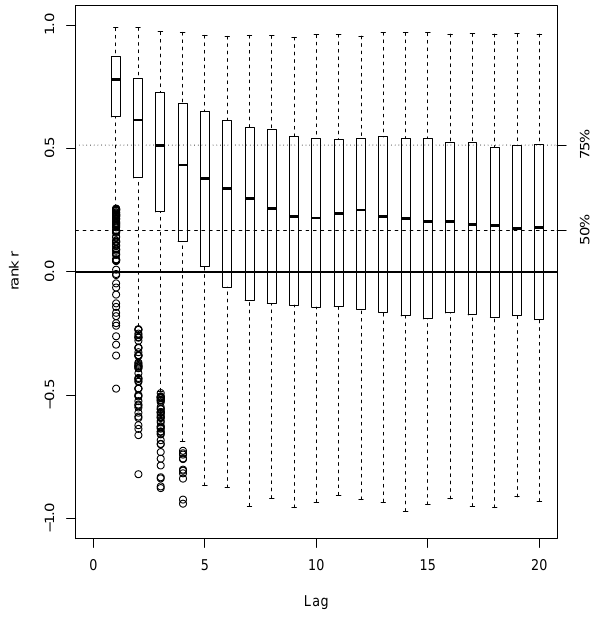
Fig. 1. Distribution of autocorrelation functions for each grid point in the Kington (1988) SLP data set, for lags between 0 and 20 days. Each box and whisker plot is drawn for a lag and all grid points with data. The boxes represent the median ( q 50 ), 25th ( q 25 ) and 75th ( q 75 ) quantiles of the distribution. The up- per whisker is min(1.5( q 75 − q 25 ) + q 50 , max ( C )); that is, circles are outliers exceeding the interquartile range. The lower whisker is max( − 1.5( q 75 − q 25 ) + q 50 , min ( C )). The horizontal dashed line represents the 50th quantile of autocorrelation values when days are picked at random. The horizontal dotted line is the 75th quantile of autocorrelation values for days picked at